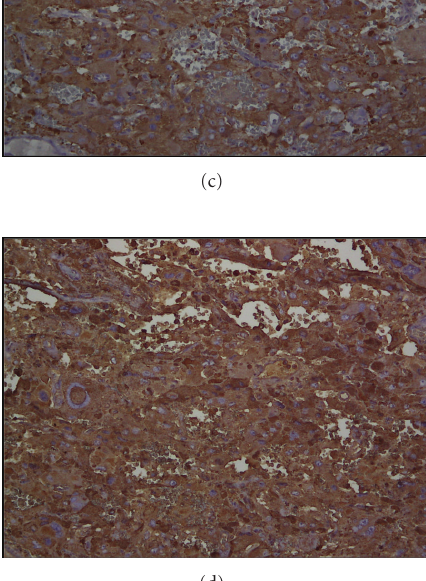
Figure 4: (a) and (b) Enlarged cystic adrenal mass filled with tan red necrotic material. (c) Hemorrhagic and fibrotic components within adrenal medulla mass (H & E; 100X). (d) Tumor cells are large with abundant pink to mauve cytoplasm and arranged in nests with capillaries in between (H & E; 400X).